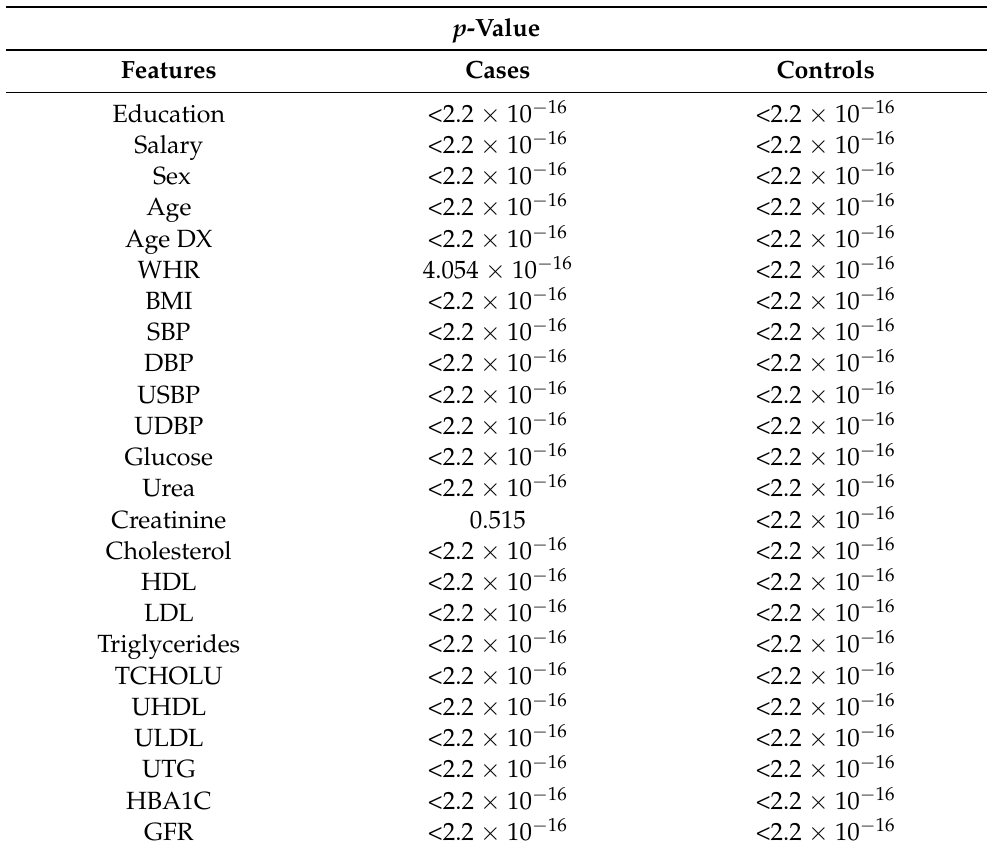
Table 5. p -value of each